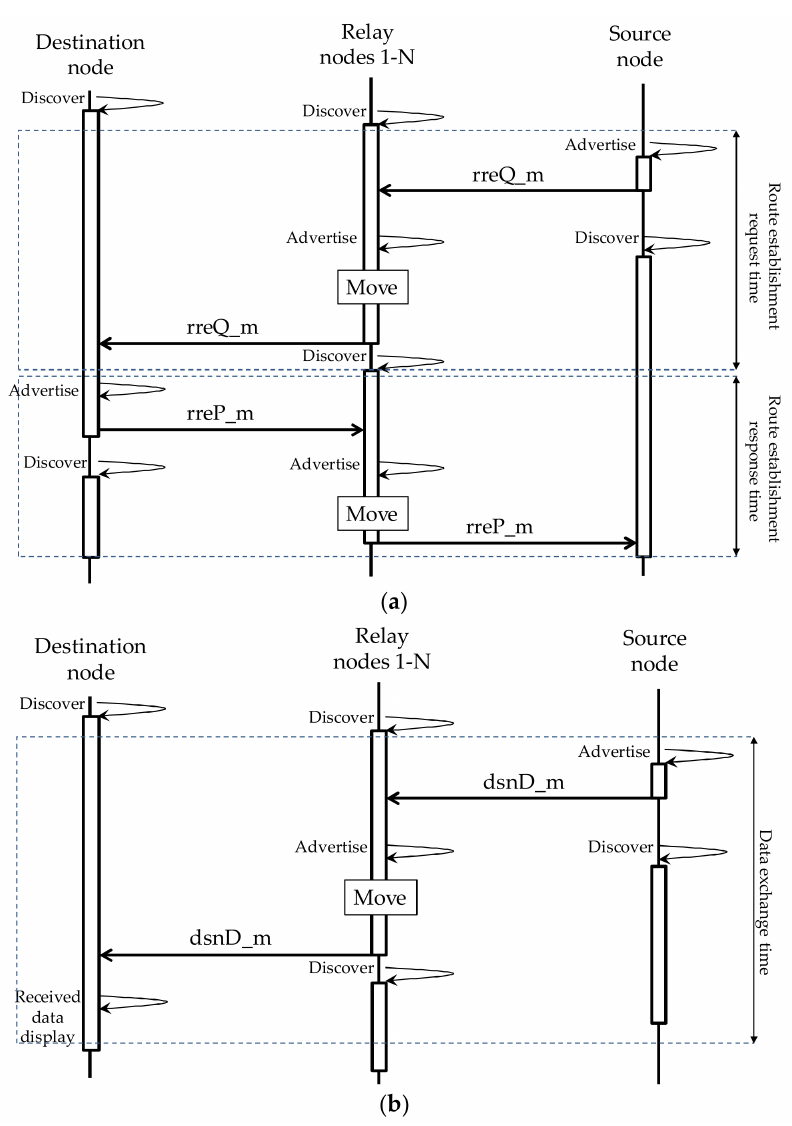
Figure 5. Sequence of message exchange for DTN communication. ( a ) Route establishment; ( b ) Data